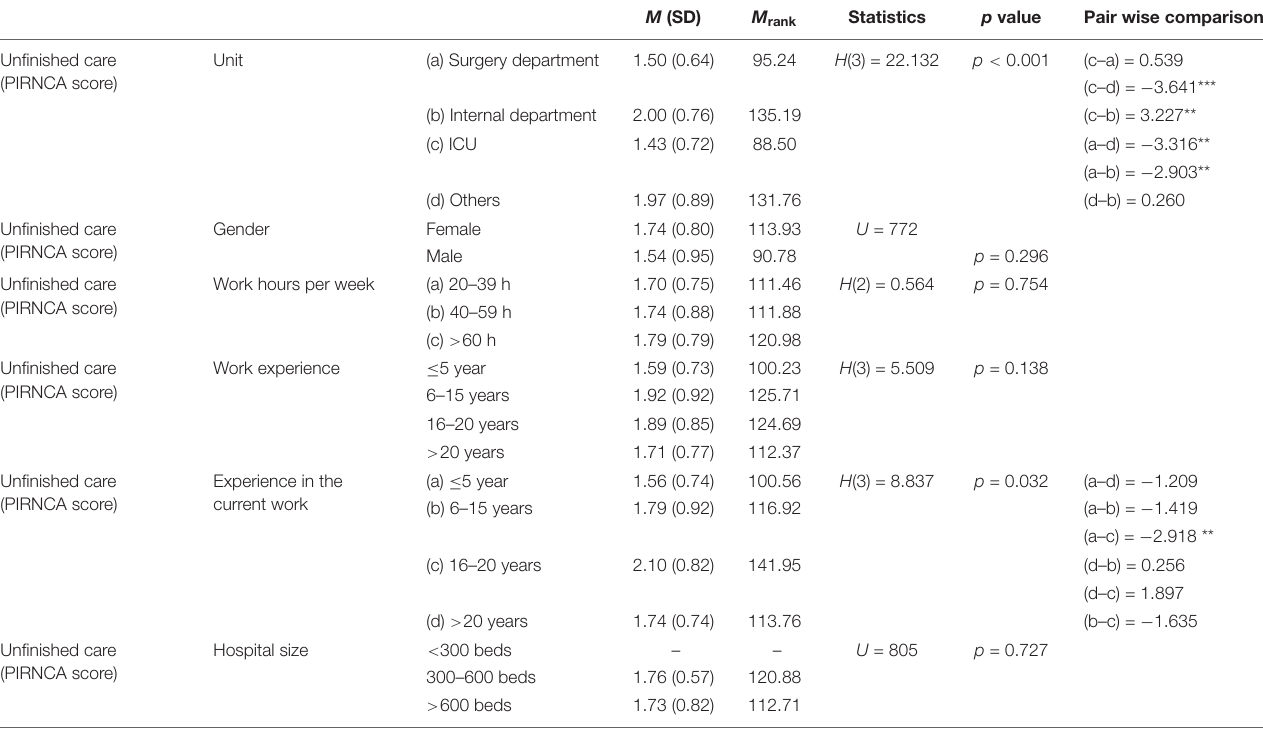
TABLE 6 | Comparison tests (Kruskal–Wallis H Test or Mann–Whitney U test) on overall missed nursing care by nurses’ work characteristics.